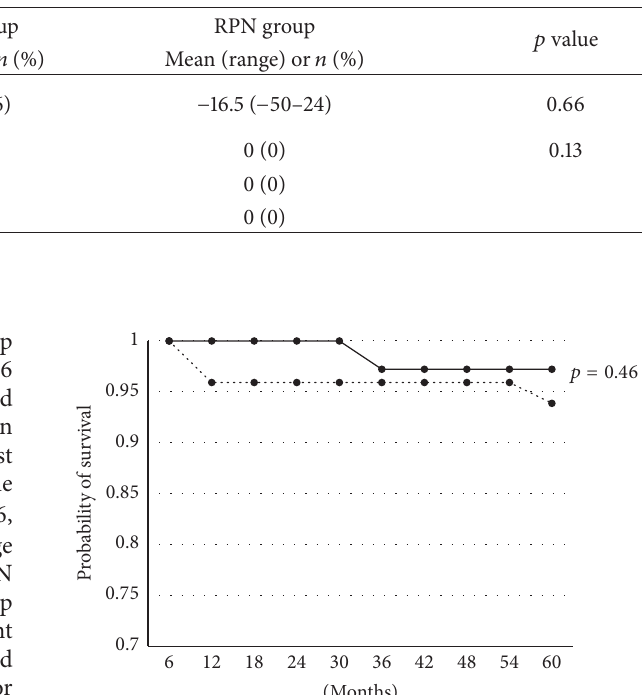
Table 3: Functional and oncologic outcomes.